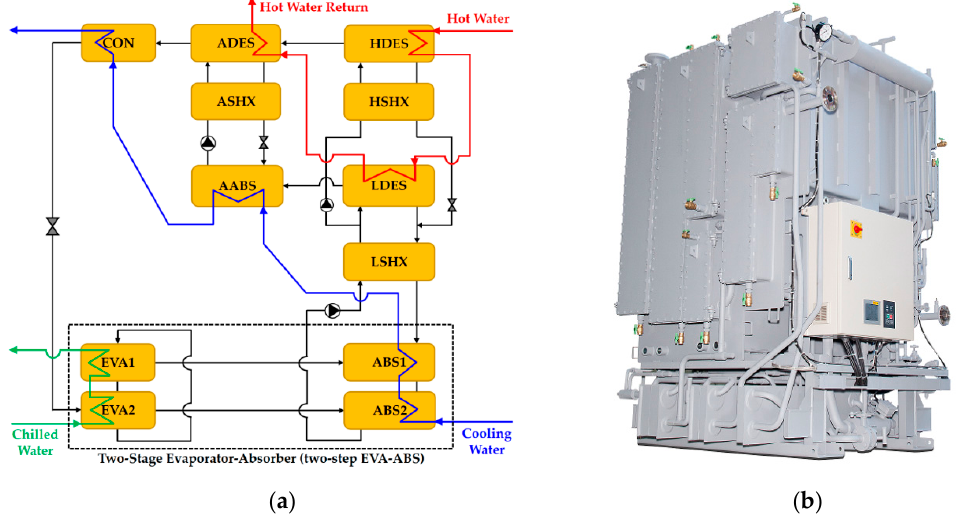
Figure 6. Single-e ff ect double-lift water / LiBr absorption chiller machine, type DXS, developed by Hitachi Johnson Controls Air Conditioning Co., Ltd. Adapted from References [16,35]. ( a ) absorption cycle schematic; ( b ) absorption chiller external view. Note: AABS = auxiliary absorber; ABS = absorber;